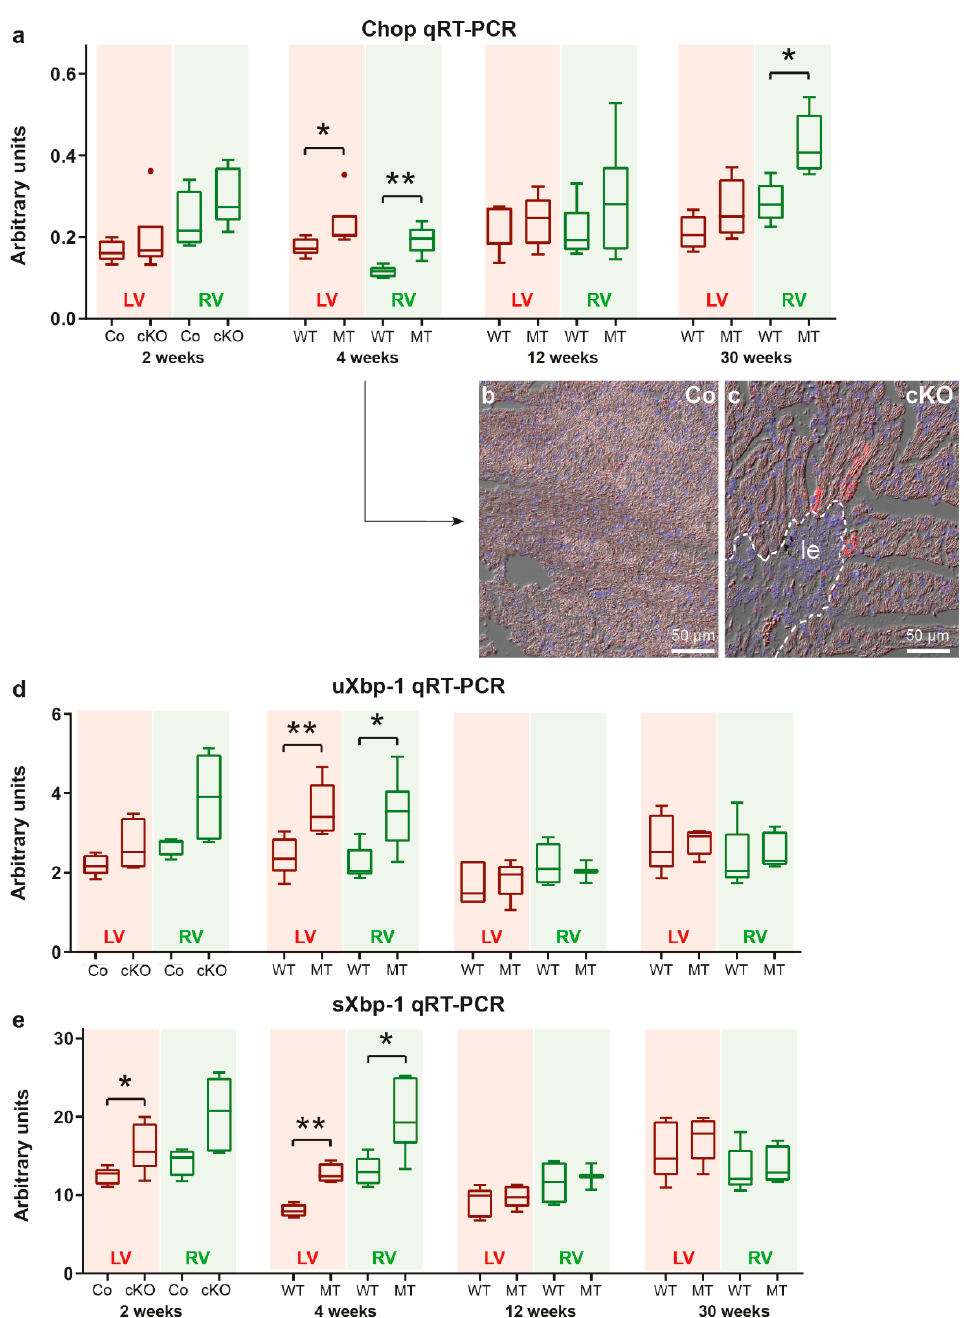
Figure 7. Molecular markers of ER stress and the unfolded protein response (UPR) are upregulated in a defined temporal and spatial manner in Dsg2 cKO (cKO) and Dsg2 MT (MT) hearts. ( a ) Tukey’s whisker plots of Chop mRNA expression in the right and left ventricles (RV and LV, respectively) of Dsg2 cKO (cKO) and Dsg2 flox(E4 − 5) control mice (Co) aged 2 weeks and Dsg2 MT (MT) and wild-type (WT) mice at the indicated time points using qRT-PCR. ( b , c ) Representative in situ hybridization of Chop mRNA in cardiac sections of 4 week-old Dsg2 cKO mice and Dsg2 flox(E4 − 5) control mice (Co). The micrographs consist of three different channels: red, Chop mRNA; blue, nuclear Hoechst 3342 staining and differential interference contrast. Left ventricles are shown. Chop mRNA is highly expressed in some cardiomyocytes adjacent to fibrotic scars (le, demarcated by a dotted line).